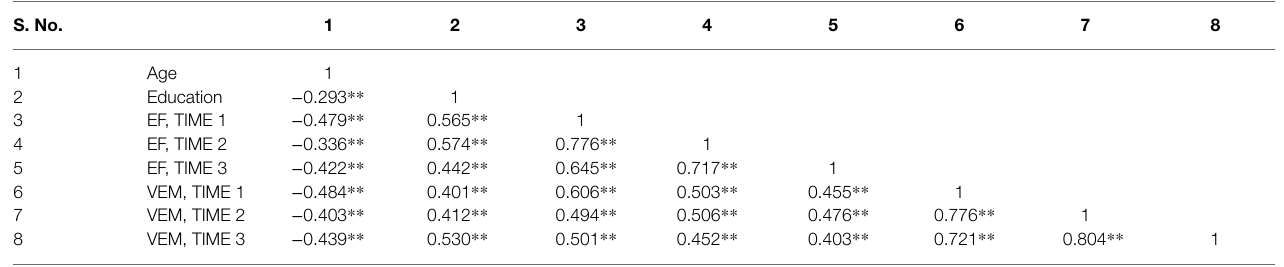
TABLE 4 | Correlations between age, education and cognitive domains. S.